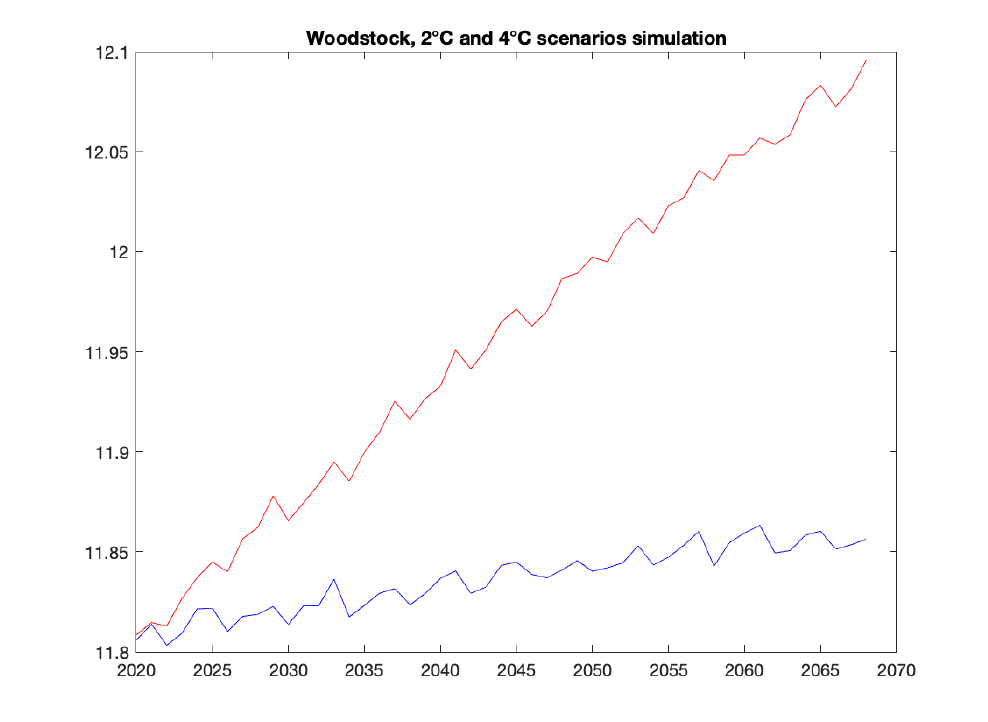
Figure 2. Simulated average corn yield (tons per hectare) between 2020 and 2068 for Woodstock under a +2 ◦ C (blue) and +4 ◦ C (red) warming